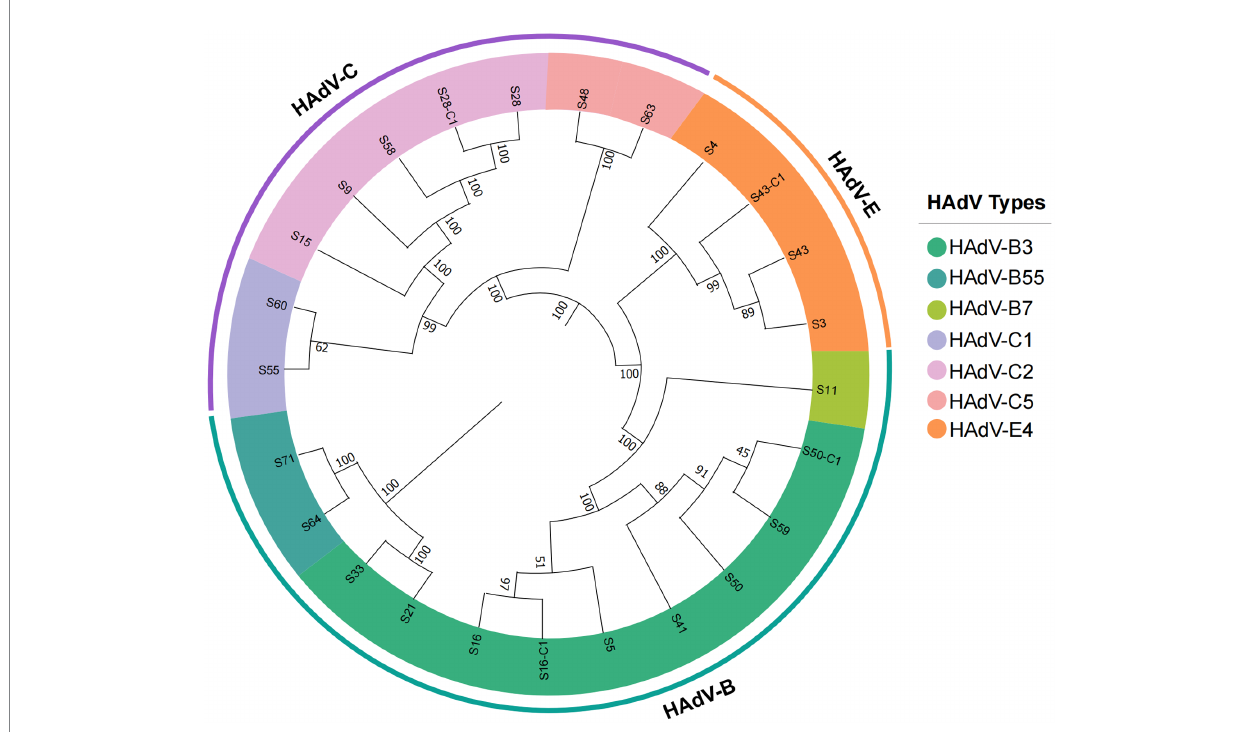
FIGURE 2 Phylogenetic analysis of all HAdV strains detected in this study based on complete genome data. The trees were constructed using the maximum likelihood method in MEGA11.0 with a bootstrap test of 1,000 replicates. According to specific HAdV species, each clade is highlighted using a color